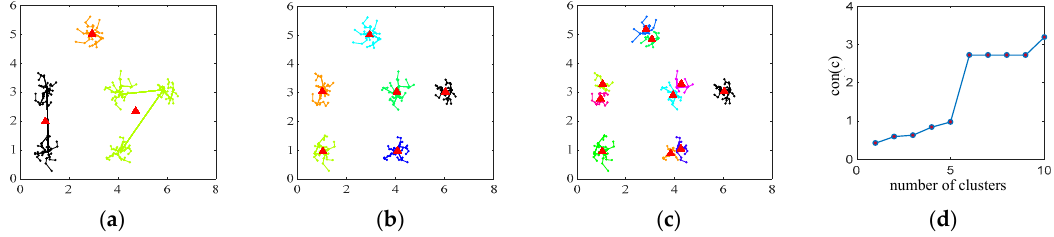
Figure 7. ( a – c ) The chains when c = 3, 6, and 10, respectively; ( d ) shows the curve of (11). Note that the points in the same color indicate that they are partitioned into the same cluster by using C-means algorithm and the sign Δ means the center of C-means.